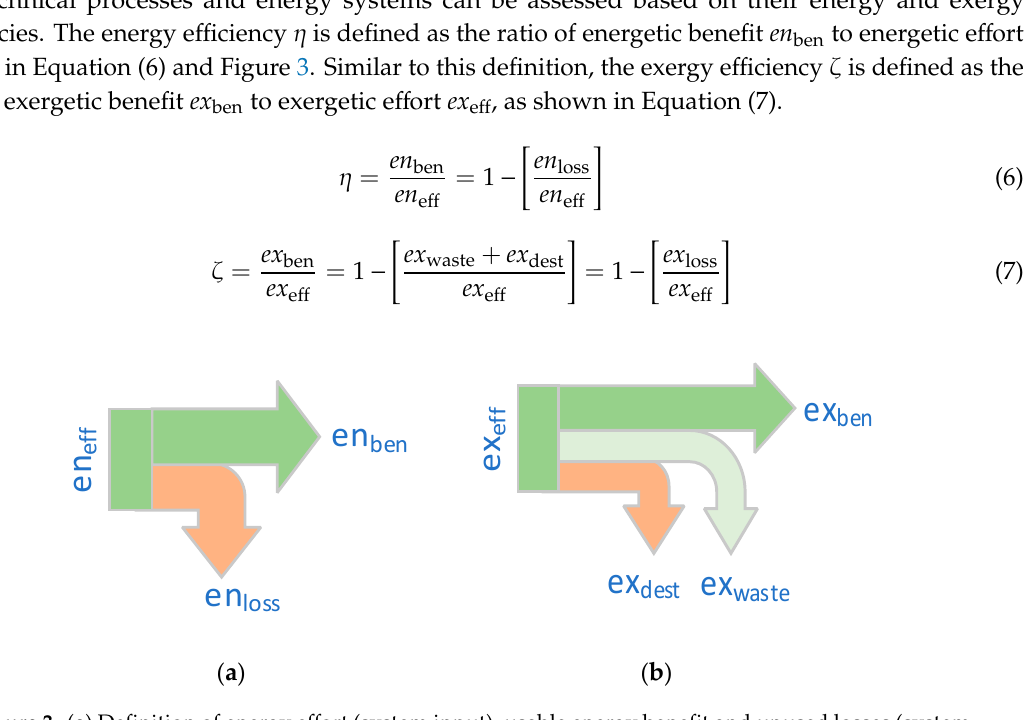
Table 2. Exergy grades for selected fuels at 25 °C and (cid:1868) (cid:2868) = 1.01325 bar [7,8,12] .